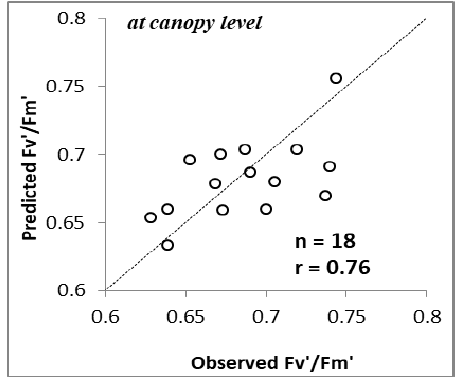
Figure-12 Predicted Fv ' /Fm ' vs Observed Fv ' /Fm